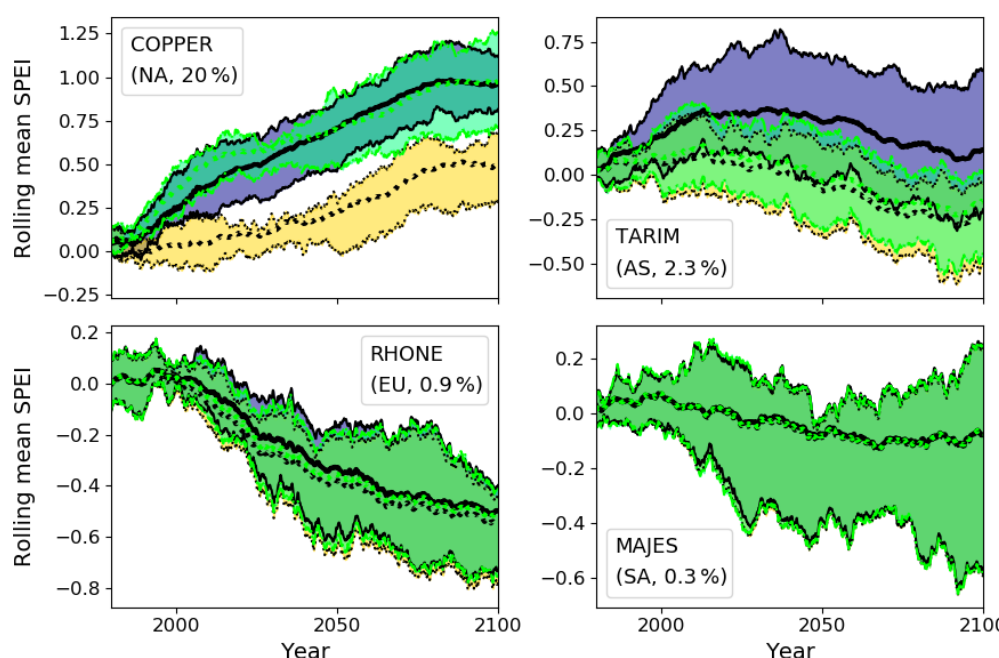
Figure B2. 30-year running ensemble mean and interquartile range of SPEI 3mo unmodified (yellow shading), with glacial runoff (blue shading), and with precipitation scaled up as described in Sect. B2.1 (green shading, bright outlines) for the RCP 4.5 scenario in four example basins. As in Fig. 1, each panel is annotated with basin name, region abbreviation, and percent glacier coverage by area. ‘NA’ indicates North America, ‘AS’ Asia, ‘EU’ Europe, and ‘SA’ South America.